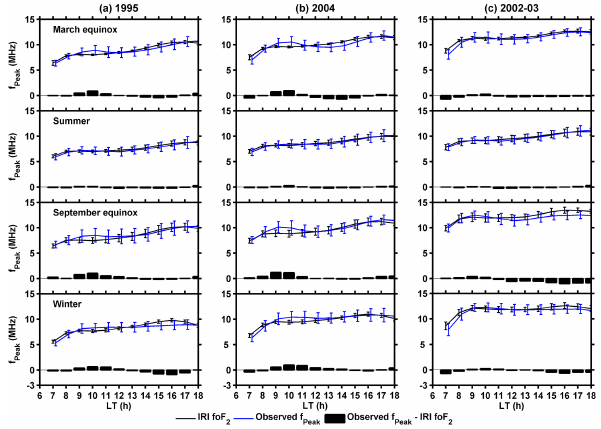
Figure 4. Same as Fig. 3, but for peak frequency (i.e., f o F2/ f o F3).